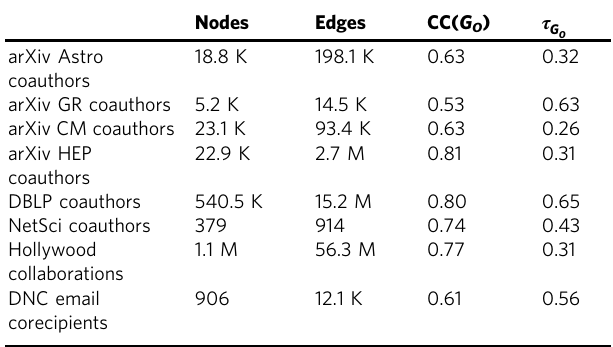
Table 2. Future work should go beyond this qualitative analysis and should attempt to measure the degree to which copying